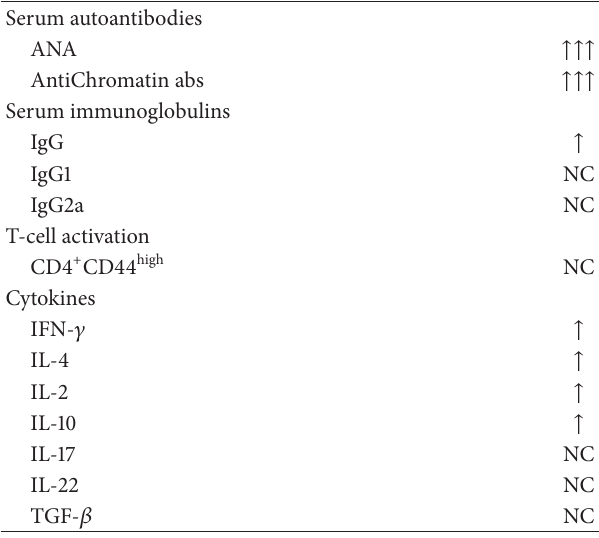
Table 2: Effect of Daf1 deletion on mHgIA ∗